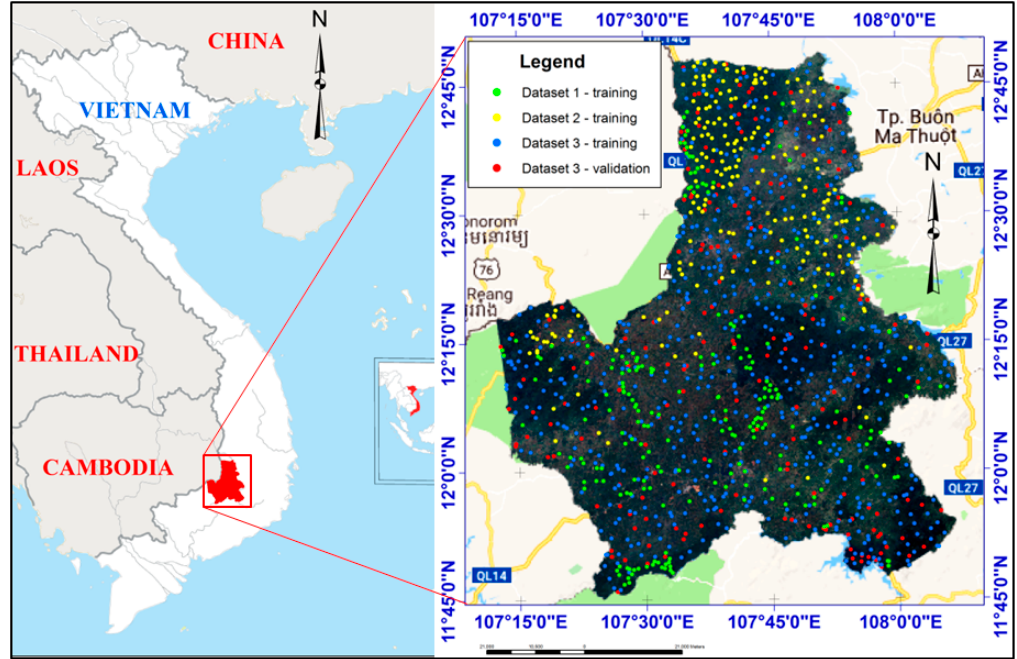
Figure 2. The study area in Dak Nong province, Vietnam, with sample unit locations